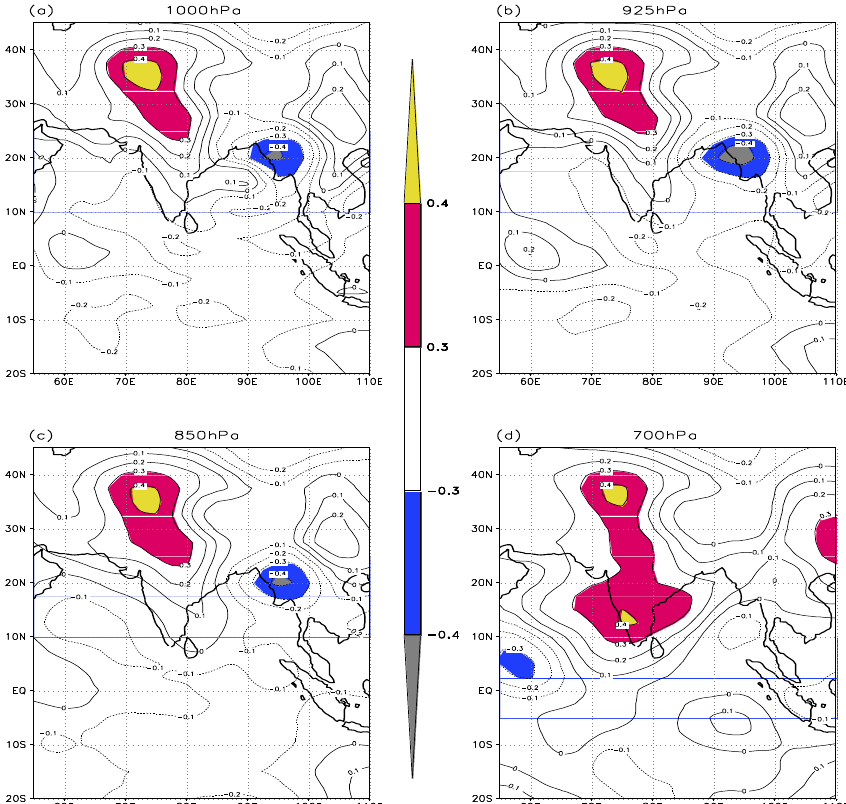
Figure 1. Spatial distribution of the correlation coefficients of ISMR with air temperature over Asian region for (a) 1000hPa (b) 925hPa (c) 850hPa and (d) 700hPa for May. Positive (negative) correlations, significant at 1% level, are indicated by yellow (gray)